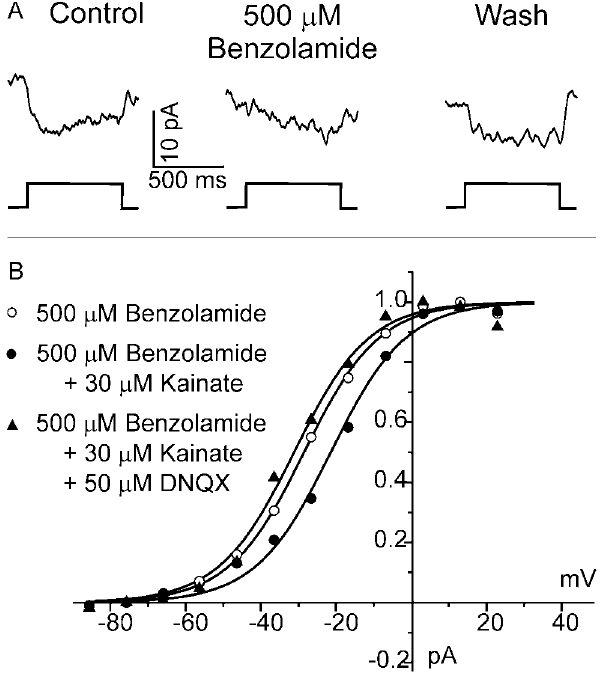
Figure 9. Benzolamide does not increase the feedback-induced inward currents in cones in the isolated goldfish retina. A , Feedback-responses elicited by a 500 ms full-field stimulus (I=0 log) delivered in the presence of a 20 m m spot of light (I=0 log) centered on a cone clamped at 2 43 mV. Current responses are shown in control (top), after application of 500 m M benzolemide (middle), and after washout (bottom). B . Feedback induced shift of the Ca-current of a cone in 100 m m benzolamide. 30 m M kainate shifts the Ca 2 + -current to more positive potentials, whereas a subsequent application of 50 m M DNQX shifts the Ca 2 + -current to more negative potentials. The difference of the half activation in kainate and in DNQX is 7.0 6 1.6 mV